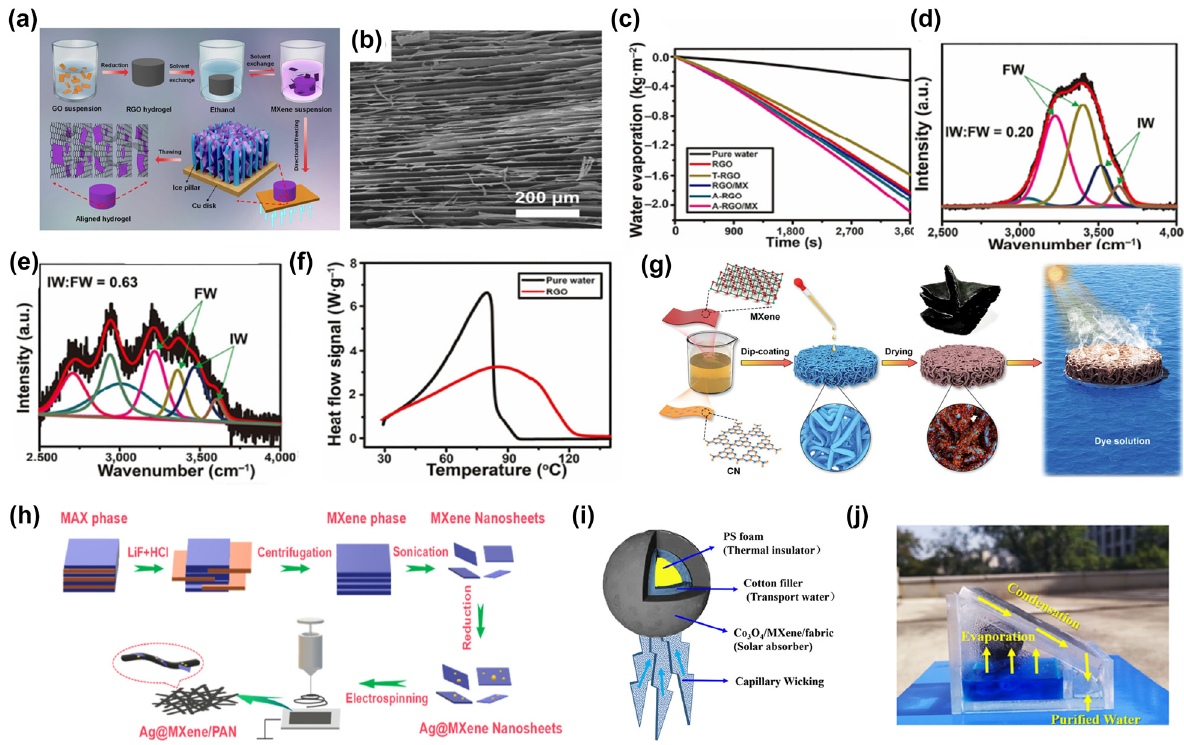
Figure 14: The fabrication and properties of A-RGO/MX hybrid hydrogel. (a) Schematic illustration of the fabrication of A-RGO/MX hybrid hydrogel. (b) SEM images of freeze-dried A-RGO/MX hydrogel. (c) Mass changes of water without or with RGO, T-RGO, A-RGO, and A-RGO/MX hydrogels under 1-sun irradiation. (d) Without and (e) with the RGO hydrogel, where FW and IW represent free water and intermediate water, respectively. (f) Thermograms of pure water and RGO hydrogel. The magnitudes of DSC signals are proportional to the heat flow during the measurement. Reproduced with permission [184]. Copyright 2020, Springer Nature. (g) Scheme for preparing the CNMC-x hybrid membrane via dip-coating the mixture of CN and the MXene in PVA solution on the surface of non-woven cotton cloth for efficient solar distillation of contaminated water and photocatalytic degradation of organic pollutants in the contaminated water. The inset shows the photograph of the folded CNMC-5 hybrid membrane to show its flexibility. Reproduced with permission [185]. Copyright 2021, The Royal Society of Chemistry. (h) Schematic diagram of the fabrication of Ag@MXene/PAN nanofiber membrane. Reproduced with permission [186]. Copyright 2021, Elsevier Ltd. (i) The biomimetic architectural structure of 3D spherical evaporator. (j) Photograph of a solar-driven evaporation device for outdoor practical applications. Reproduced